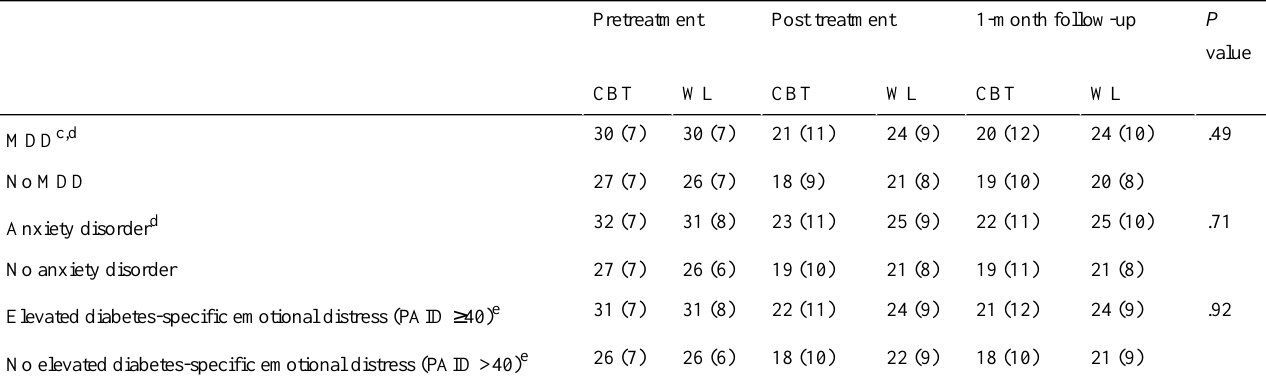
a Center for Epidemiologic Studies Depression scale. b Data are given as mean (SD). Statistical tests relied on generalized estimating equation analyses. P values indicate level of significance of effect modification. All analyses are adjusted for baseline CES-D scores, baseline between-group differences on sociodemographic variables, and differences in time between pretreatment and posttreatment. Data are uncorrected. c Major depressive disorder.